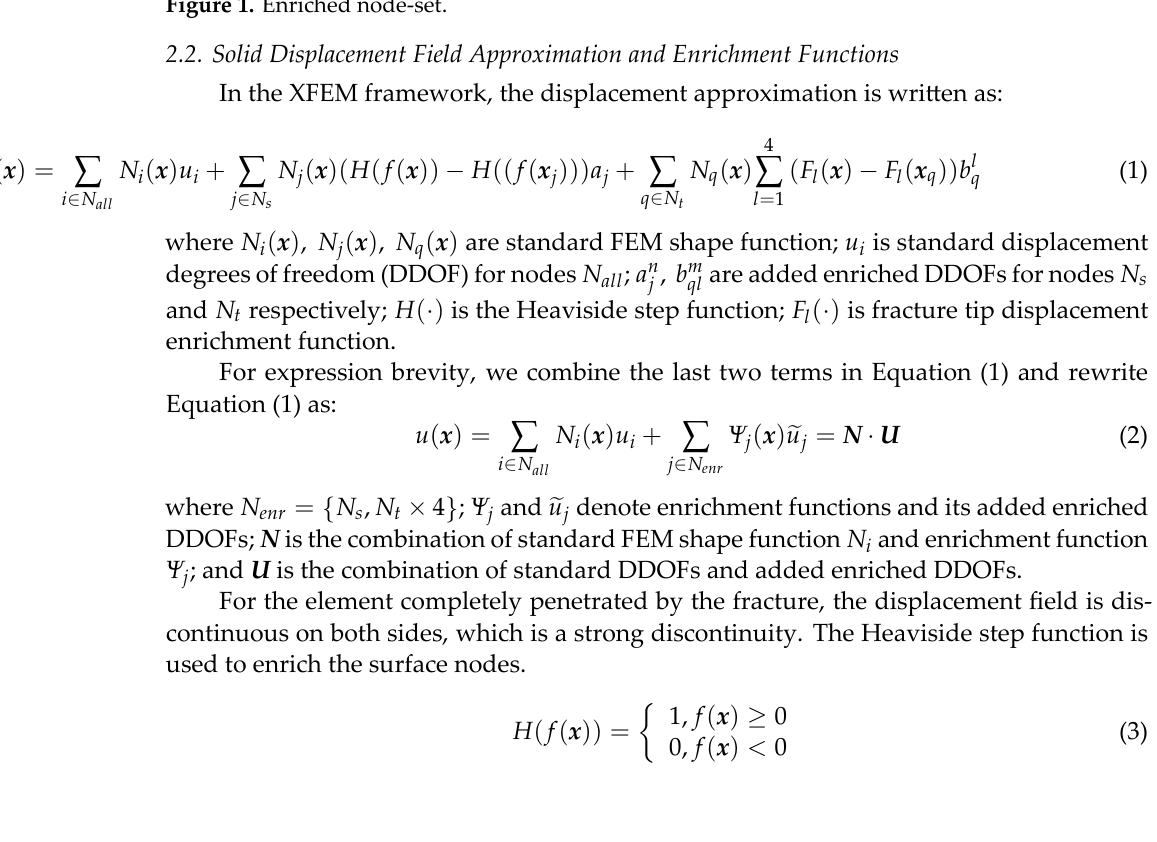
Figure 1. Enriched node-set.